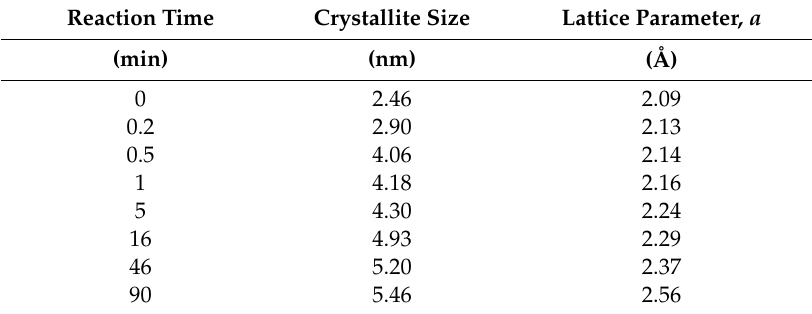
Table 1. Calculated crystallite sizes and lattice parameters of Mn-doped CdSe QDs at various reaction times.